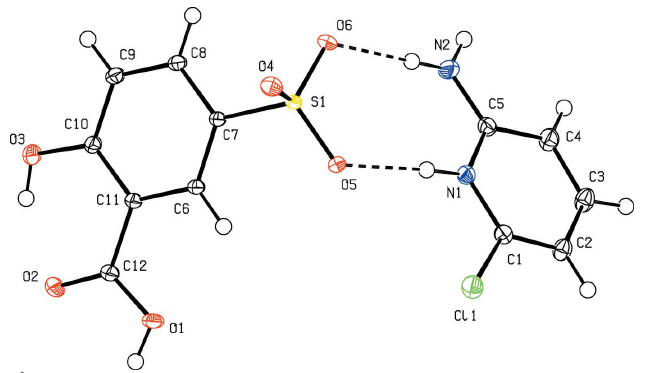
Figure 1 The asymmetric unit of the title compound. Displacement ellipsoids are drawn at the 30% probability level.